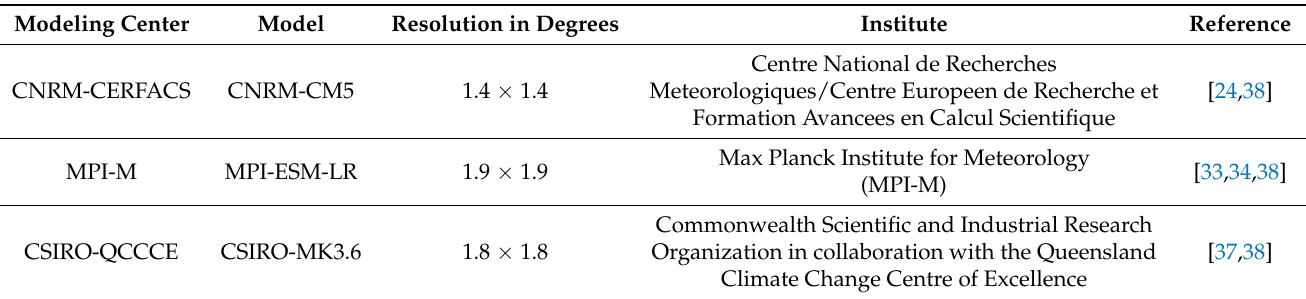
Table 1. CMIP5 global climate models considered in this